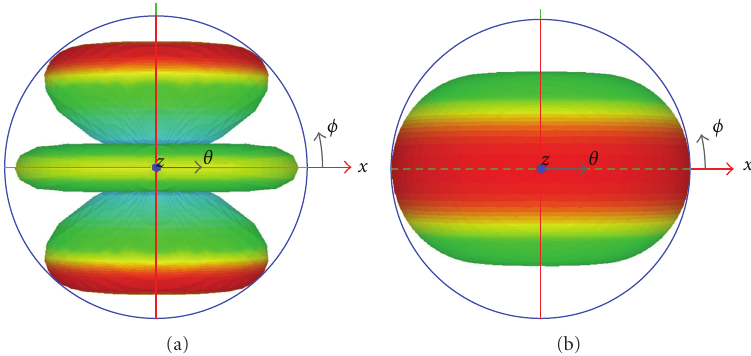
Figure 2: Radiation pattern of dipole antenna in third-order resonance: (a) standard RF dipole and (b) nanoantenna.